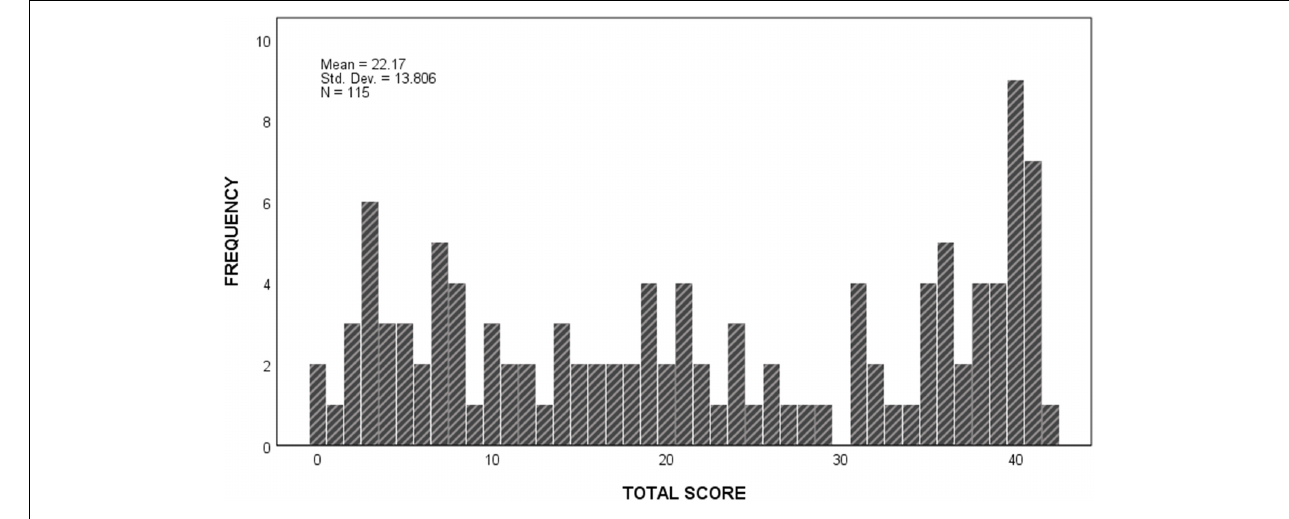
FIGURE 6 | Frequency distribution of total fTORT scores. TABLE 4 | Item-total statistics and loadings on first principal